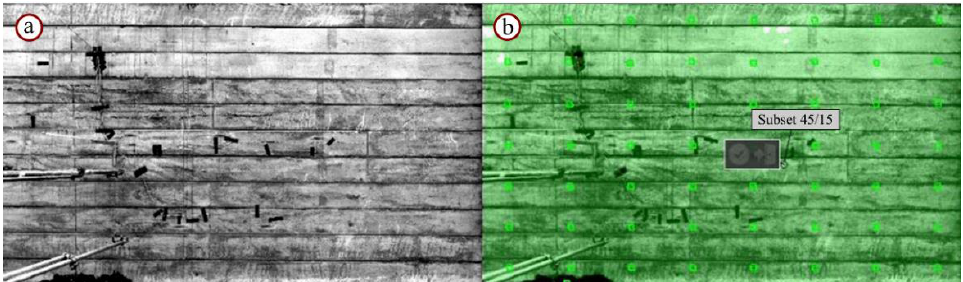
Figure 16. Improved pattern recognition for Strip 1 (Canon 6D). ( a ) Captured image with optimized grey distribution. ( b ) Recognized areas after optimization with subset 45/15.